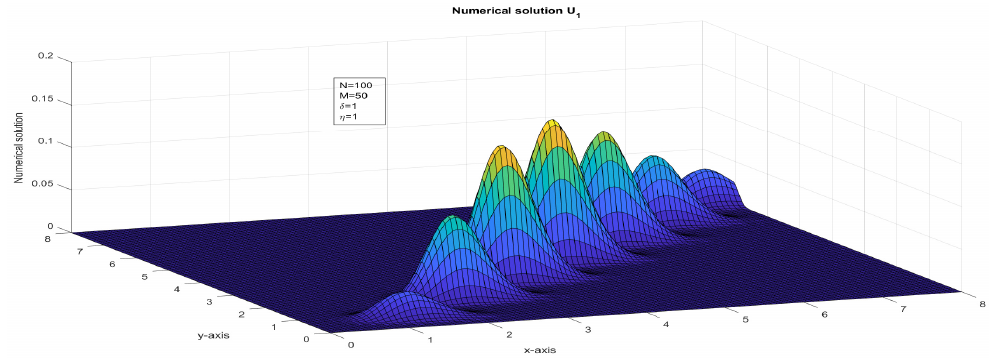
Figure 10. The surface plot illustrates the numerical solution, U 2 , of Example 2.